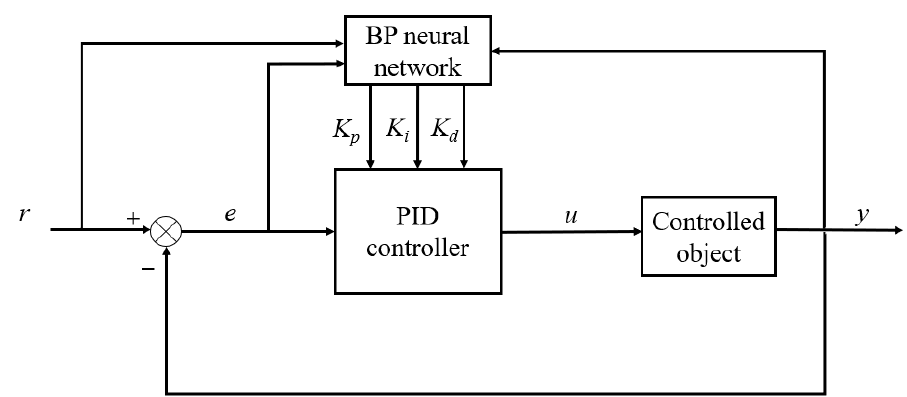
Figure 8. Structure of PID control system based on BP neural network.